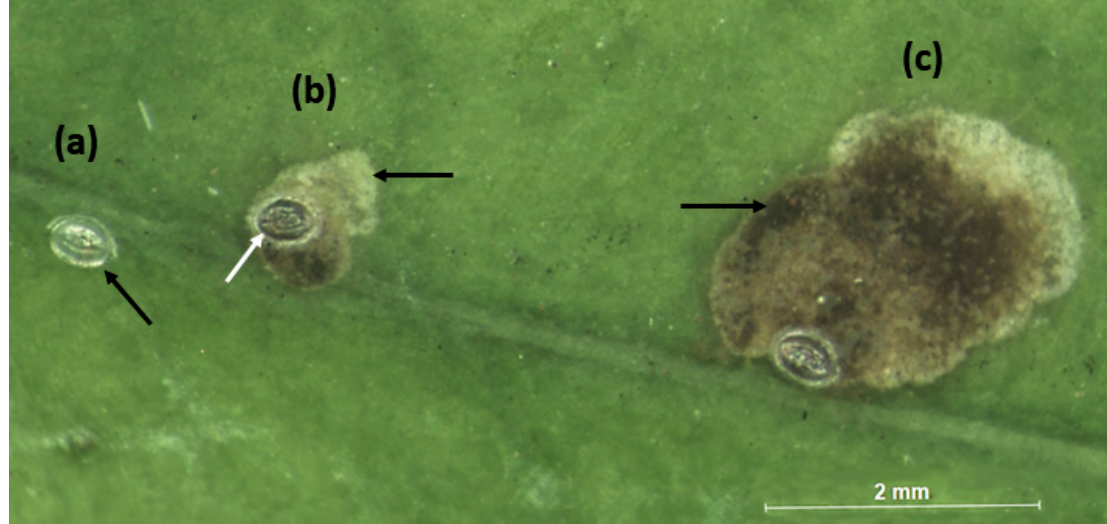
Figure 3. L. coffeella egg hatching and mine progression: ( a ) Unhatched eggs have a translucent structure, the arrow indicates a freshly oviposited egg; ( b ) after hatching, the eggshell becomes darker (white arrow) and the larva penetrates the leaf under the egg and starts feeding, forming a light green mine (black arrow); ( c ) enlargement of the mine. The black arrow indicates the dark color of the mine due to residues left behind by the larva.